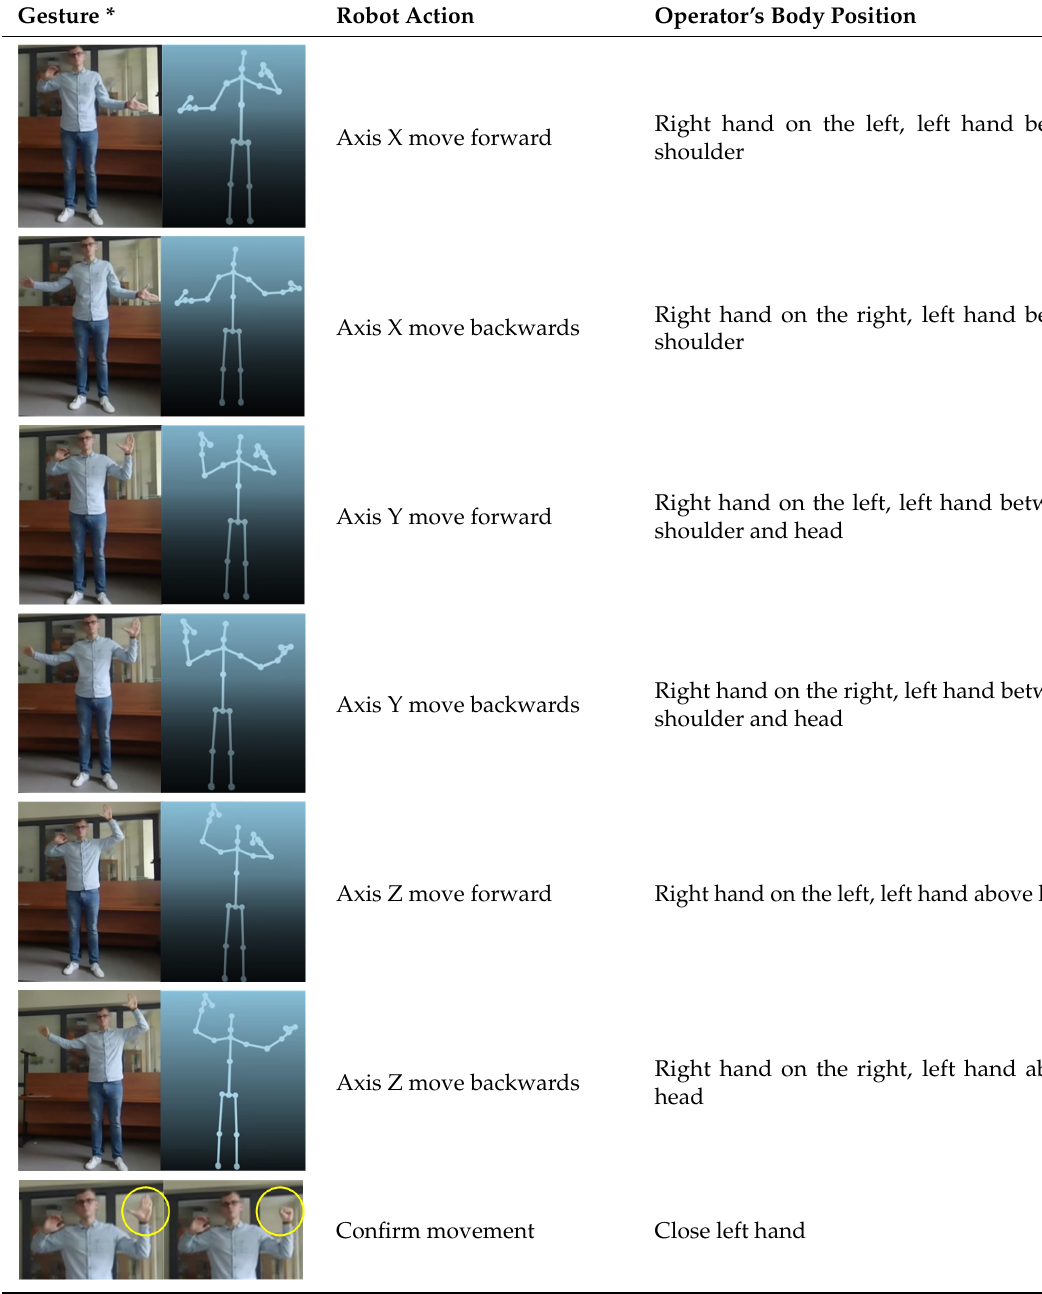
Table 1. Gestures used in robot